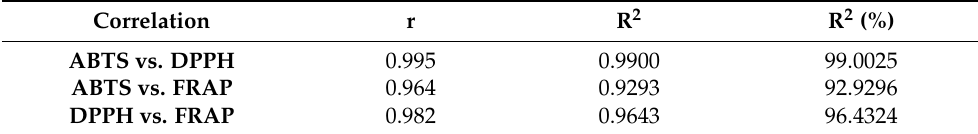
Table 10. Correlation coefficients between antioxidant methodologies. Correlation r R 2 R 2 (%) ABTS vs. DPPH 0.995 0.9900 ABTS vs. FRAP